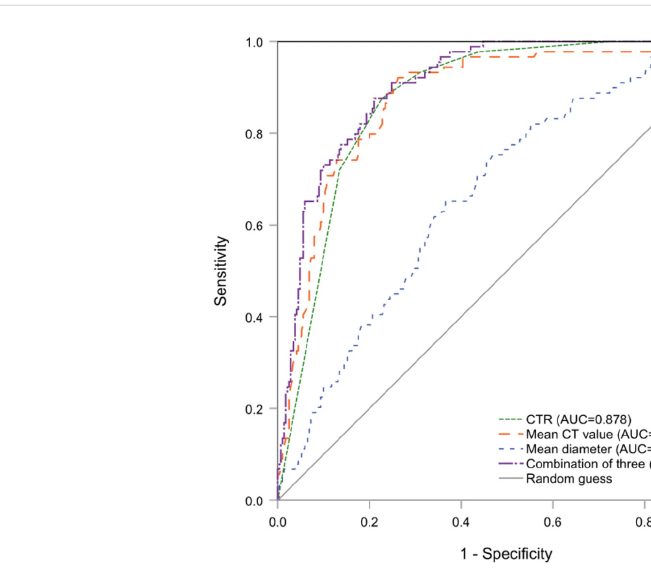
among these three survival curves (all P< .001) (Figure 3D). For the histologic grades, the 3- and 5-year DFS rates were 100% and 100% for grade 1, 95.2% and 93.8% for grade 2, and 63.9% and 48.5% for grade 3, respectively, and there were signi fi cant differences among these curves (Figure 3E). The 3- and 5-year DFS rates were 100% and 100% for cTis/ cT1mi/cT1a, 90.8% and 85.1% for cT1b, 60.5% and 46.7% for cT1c, and 40% and 0% for cT2a, respectively, and the log-rank test revealed signi fi cant differences among these curves (all P< .001) (Figure 3F).